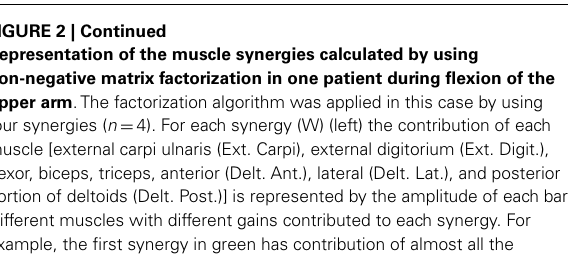
flexor, biceps, triceps, anterior (Delt. Ant.), lateral (Delt. Lat.), and posterior portion of deltoids (Delt. Post.)] is represented by the amplitude of each bar.